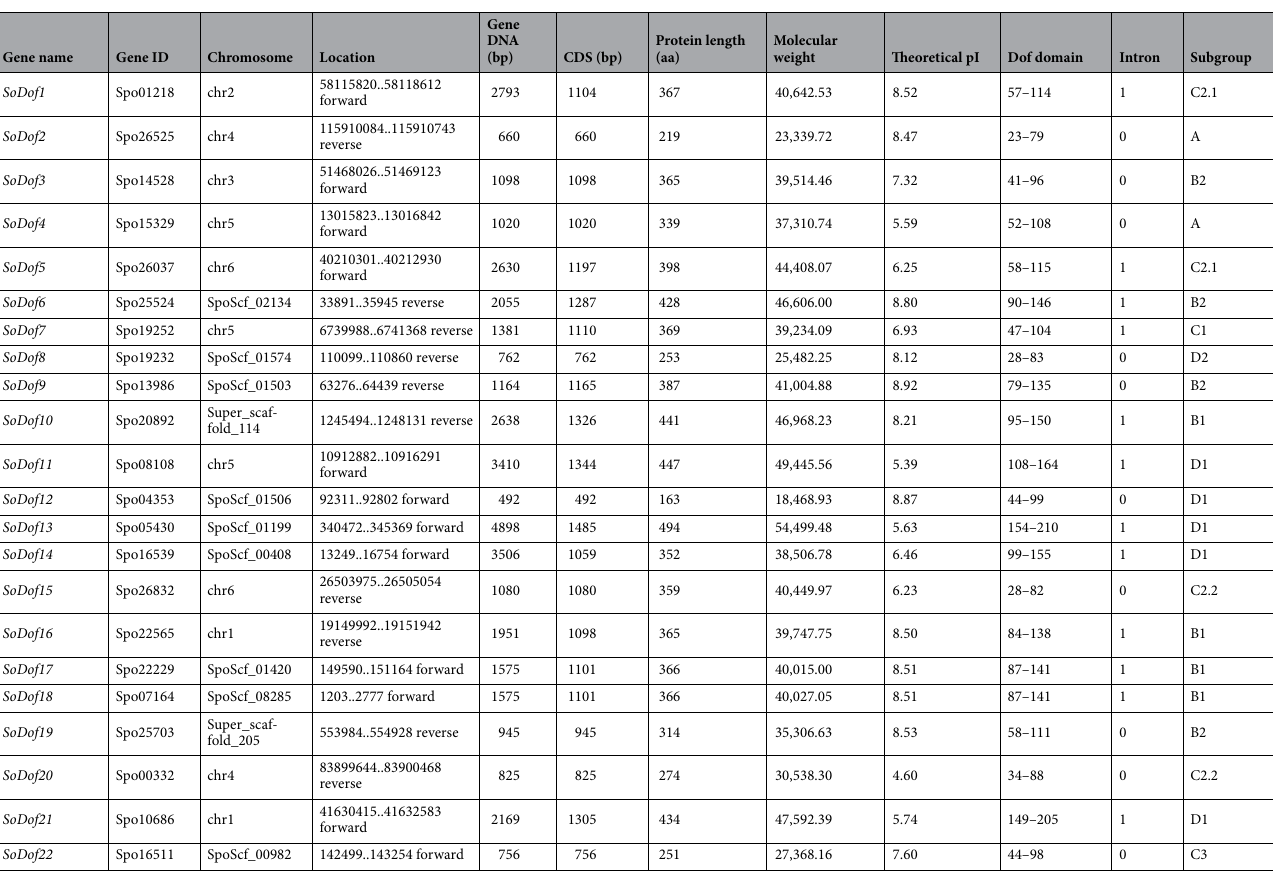
Table 1. Spinach Dof genes and their related information. Forward means that the gene is located on the negative stand of chromosome; reverse means the gene is located on the positive stand of